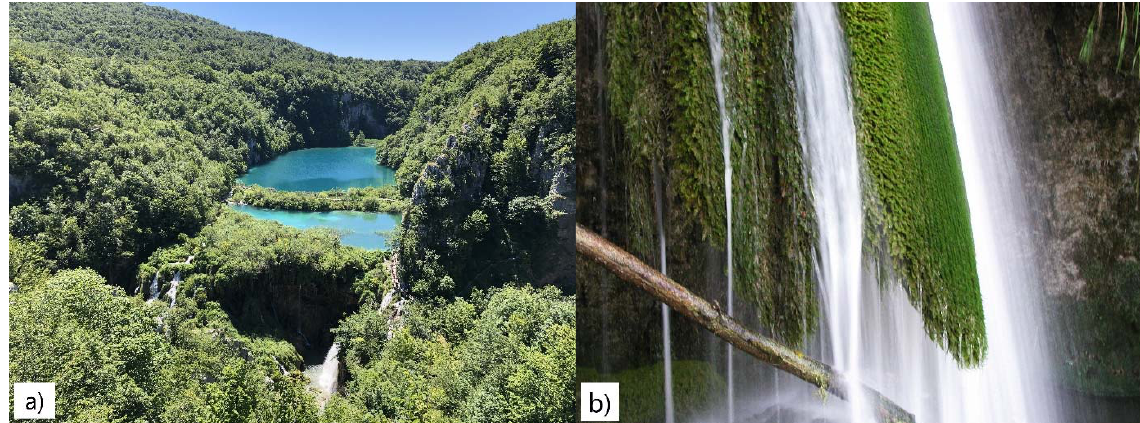
Figure 3. Tufa barriers (photo: Plitvi č ka Jezera National Park staff): ( a ) at the exit from the lake system, ( b ) detail of biogenic periphyton on the tufa barrier.